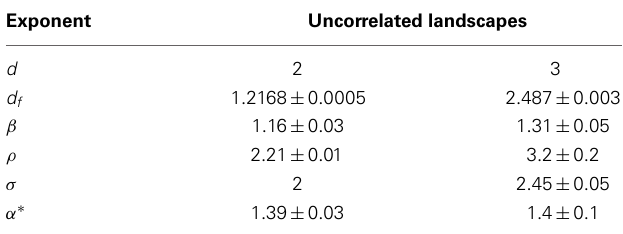
Table 2 | Exponents for the impact of perturbations on watersheds, calculated for uncorrelated artificial landscapes in two and three dimensions, from [34, 39, 55,